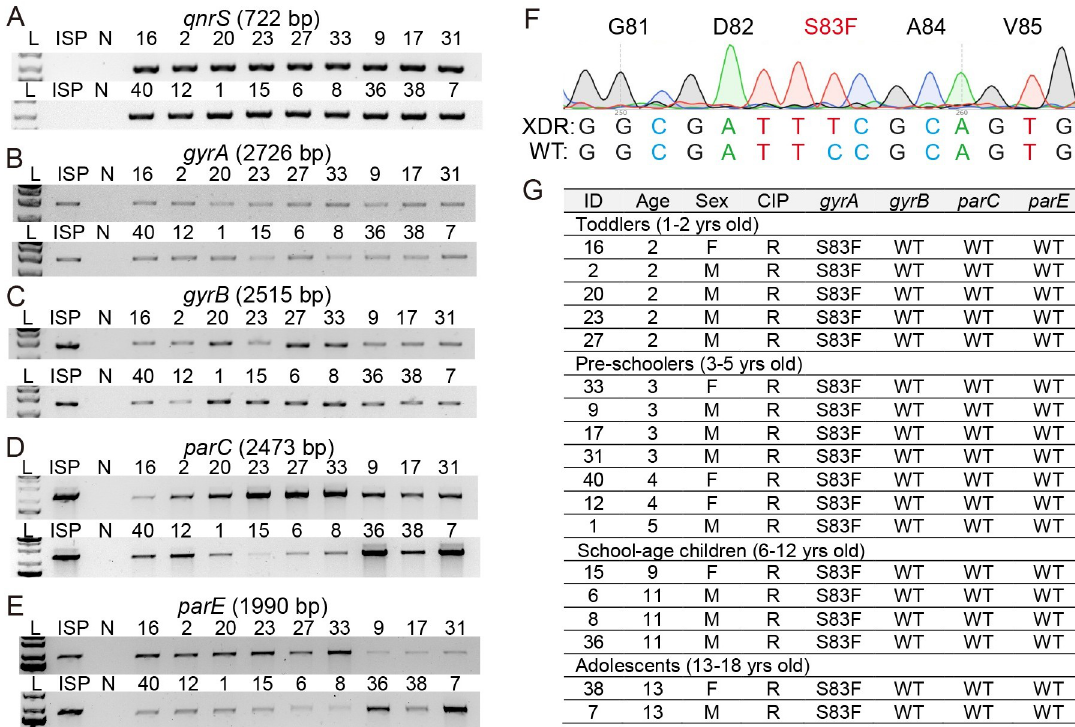
Fig 3. Molecular basis of fluoroquinolone-resistance among XDR S . Typhi isolates. A-E , PCR reactions for qnrS ( A ), gyrA ( B ), gyrB ( C ), parC ( D ), and parE ( E ). See S4 Table for details. ISP, antibiotic-susceptible S . Typhi ISP2825. N, negative control containing all PCR components except for S . Typhi genomic DNA. F , Representative sequencing chromatogram showing GyrA S83F mutation. G , Summary of PCR amplicon sequencing analysis for gyrA , gyrB , parC , and parE . See S6 Table for additional information. WT, wild type for the known